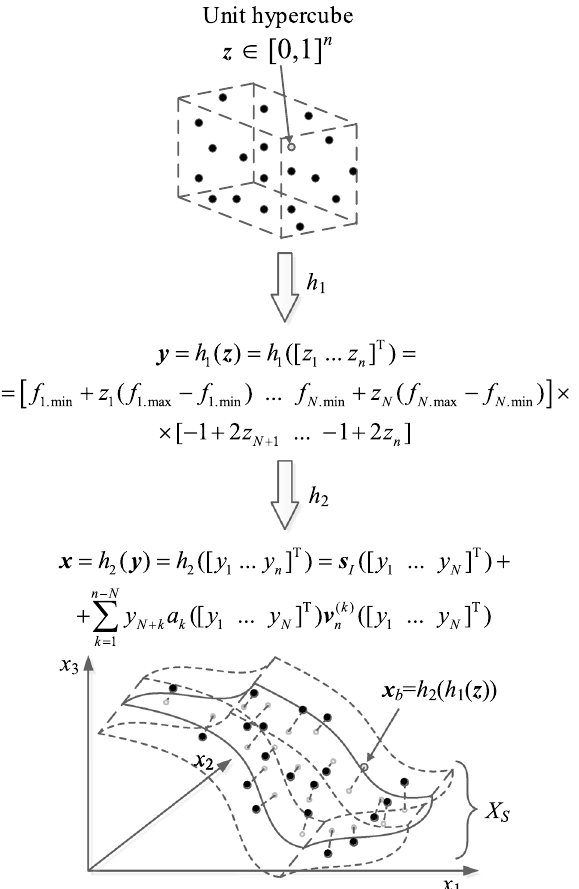
Figure 5. Conceptual illustration of the training data sampling process: (i) samples distributed according to Latin Hypercube Sampling (LHS) 81 (top), (ii) mapping onto the Cartesian product of the performance figure space F and [−1,1] n – N using function h 1 (middle), (iii) black circles mark data samples projected onto the confined domain X S using function h 2 (bottom); gray circles indicate the samples distributed over the image of design space F prior to orthogonal